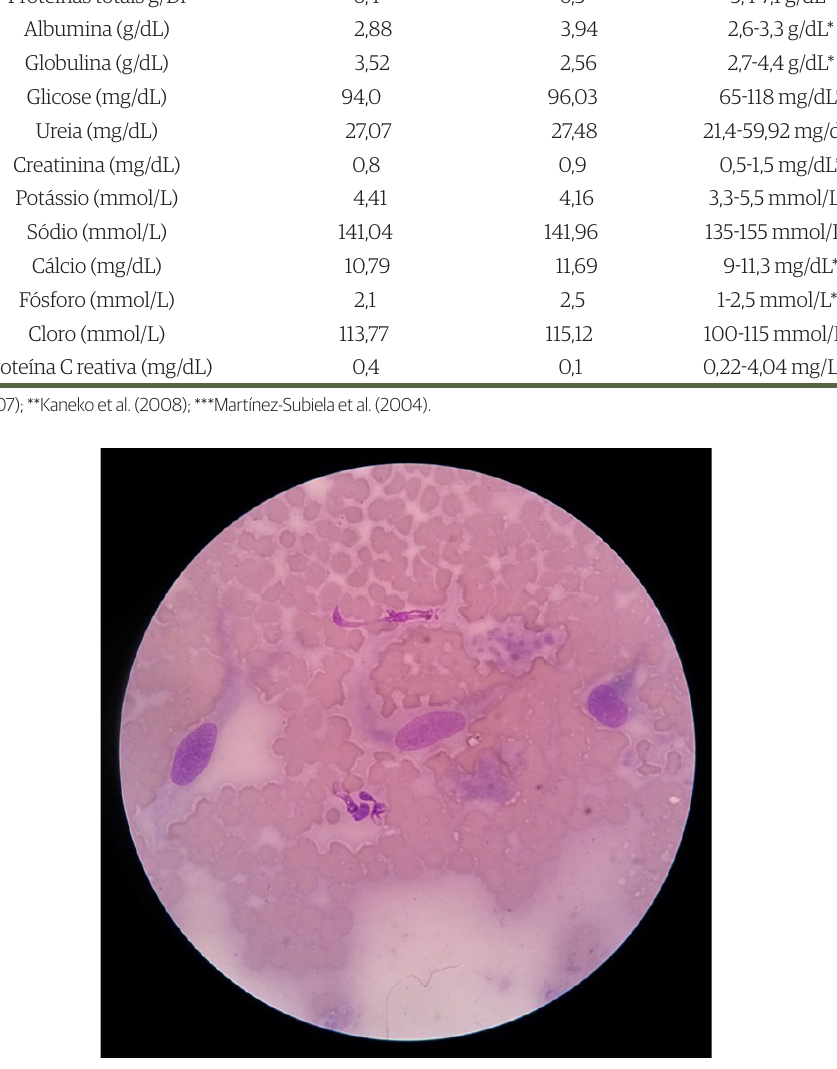
Figura 2. Citologia apresentando baixa celularidade, poucas células individuais ovaladas, núcleo ovalado a discretamente arredondado, com cromatina moderamente grosseira, nucléolos pouco proeminentes e por vezes múltiplos, citoplasma basofílico contendo vacúolos e bordos citoplasmáticos indistintos, imersa em fundo de lâmina contendo inúmeras hemácias. Presença de moderada quantidade de neutrófilos. Panótico. Obj.